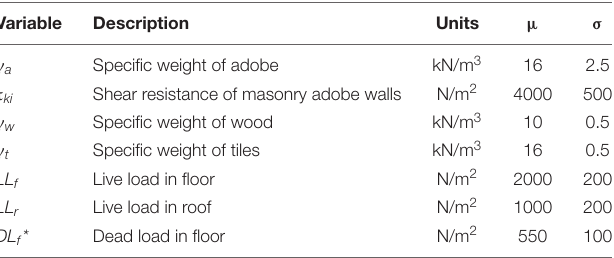
TABLE 2 | Parameters used for the estimation of the capacity curves of the synthetic buildings. Variable Description